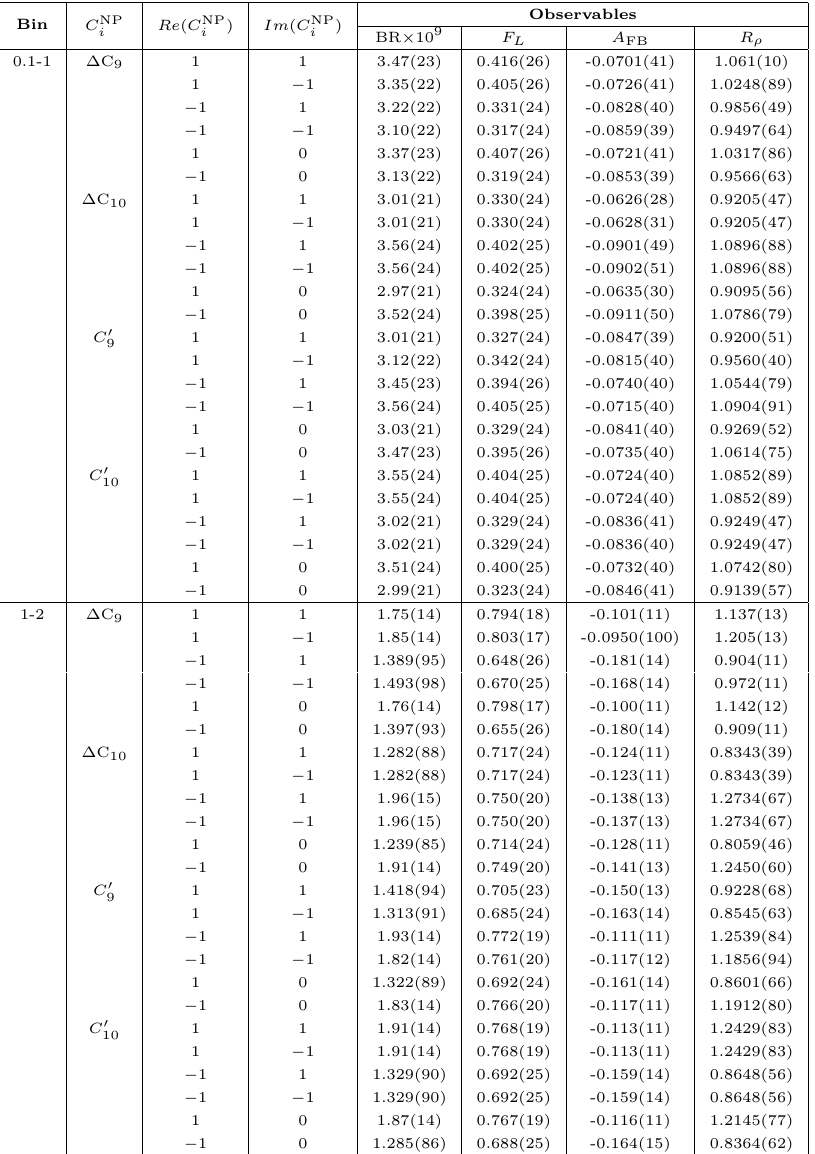
and C 0 for the 9 , 10 9 , 10